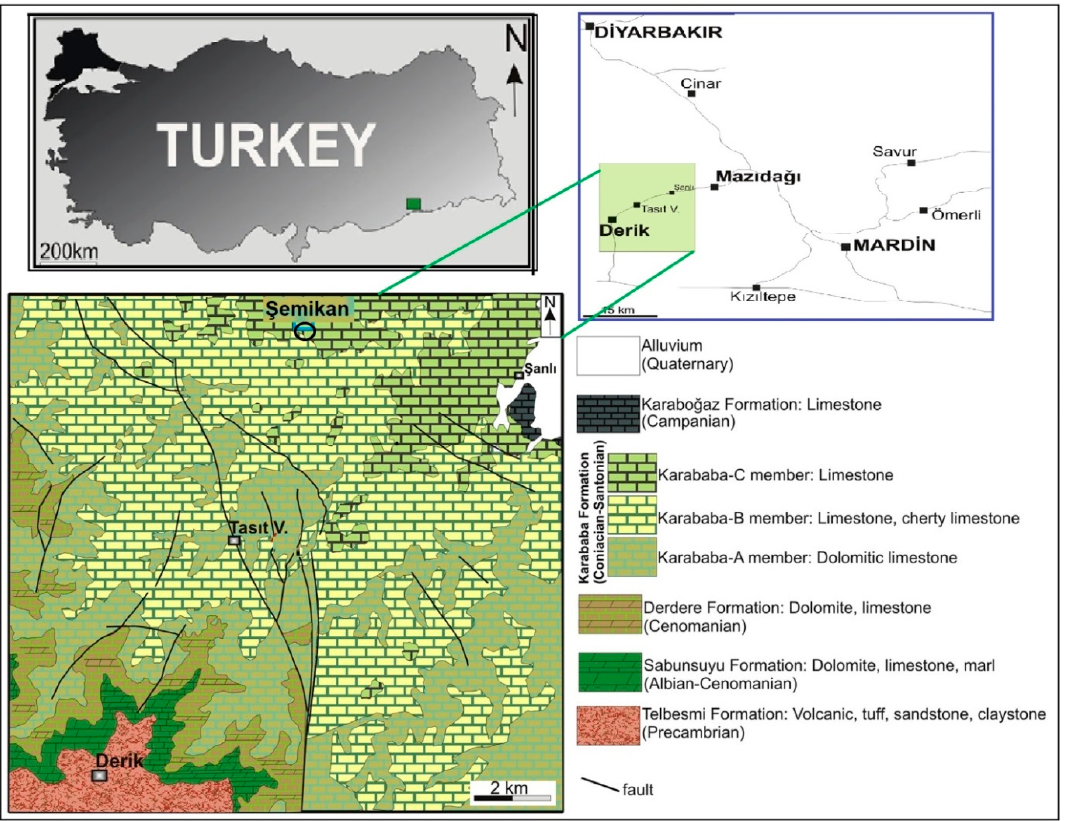
Figure 2. Generalized geological and location map of Maz ı da ğ ı phosphate deposit and its surround- ing area. Data from [37].